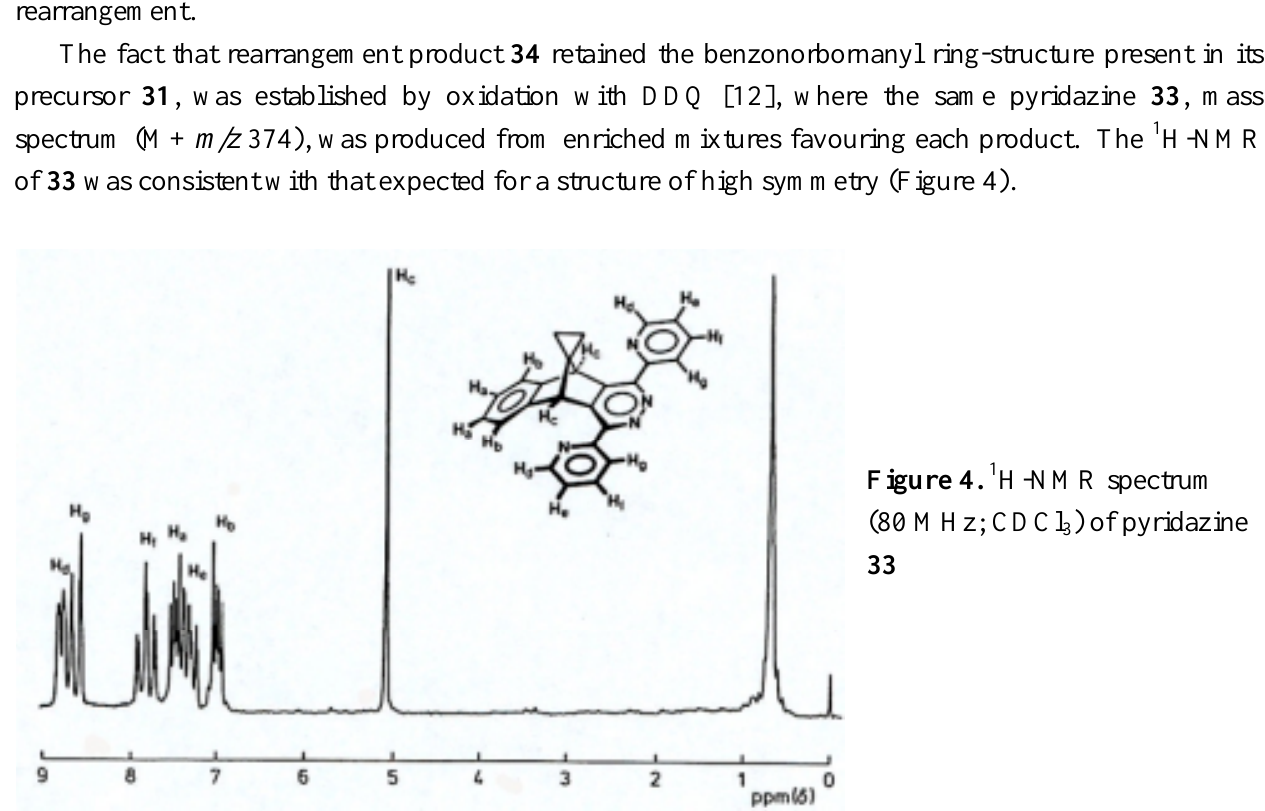
) of pyridazine 3